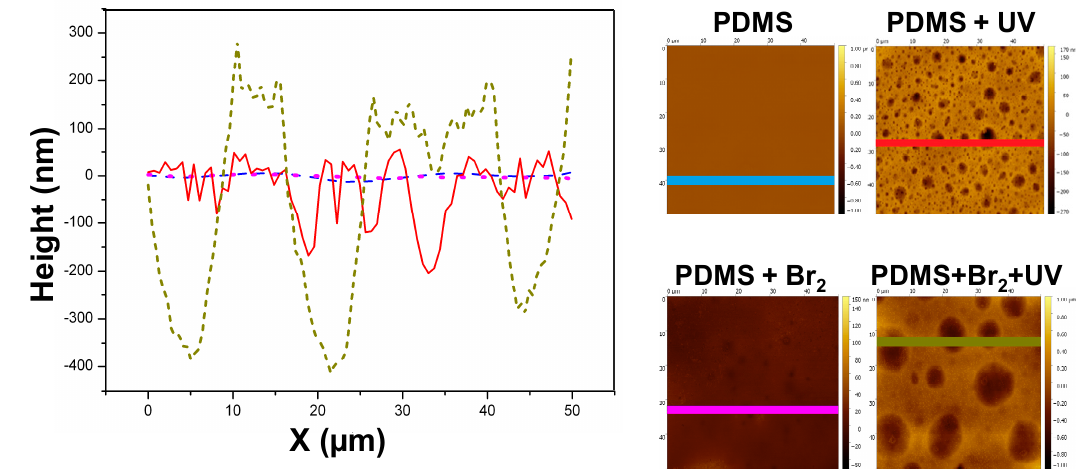
Figure 10. Height profiles of AFM, calculated on the images and lines shown below. The symbol X ( μ m) represents a distance on the indicated straight line, measured from the left to the right .